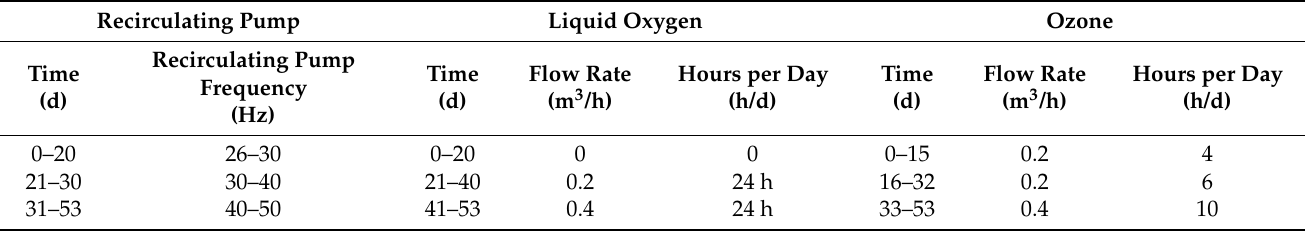
Figure 1. Flow chart depicting the recirculating aquaculture system. Table 1. Variations in the recirculating pump frequency, the liquid oxygen flow rate, and the ozone flow rate over time during the RAS culture period.